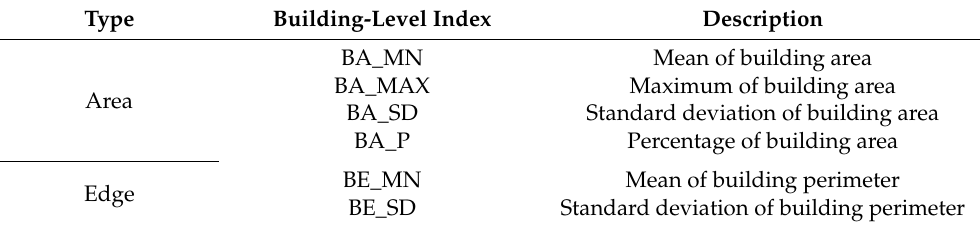
Table 2. Building-level metrics of TAZs.